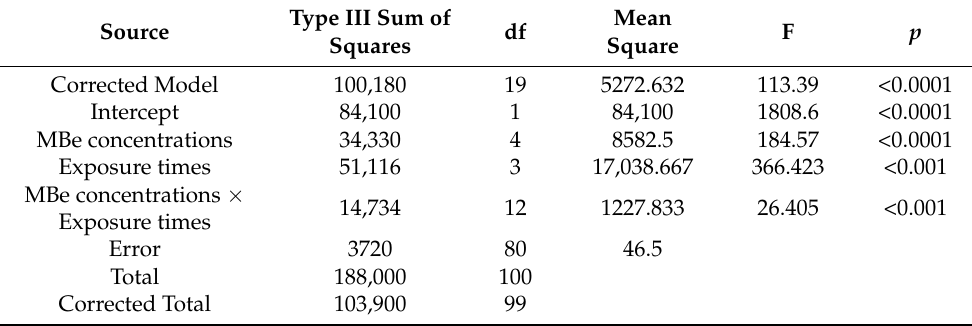
Table 3. Two-factor repeated measures ANOVA results testing the effects of different concentrations and exposure times on the fumigation toxicity of methyl benzoate (MBe) against adults of Plodia interpunctella .